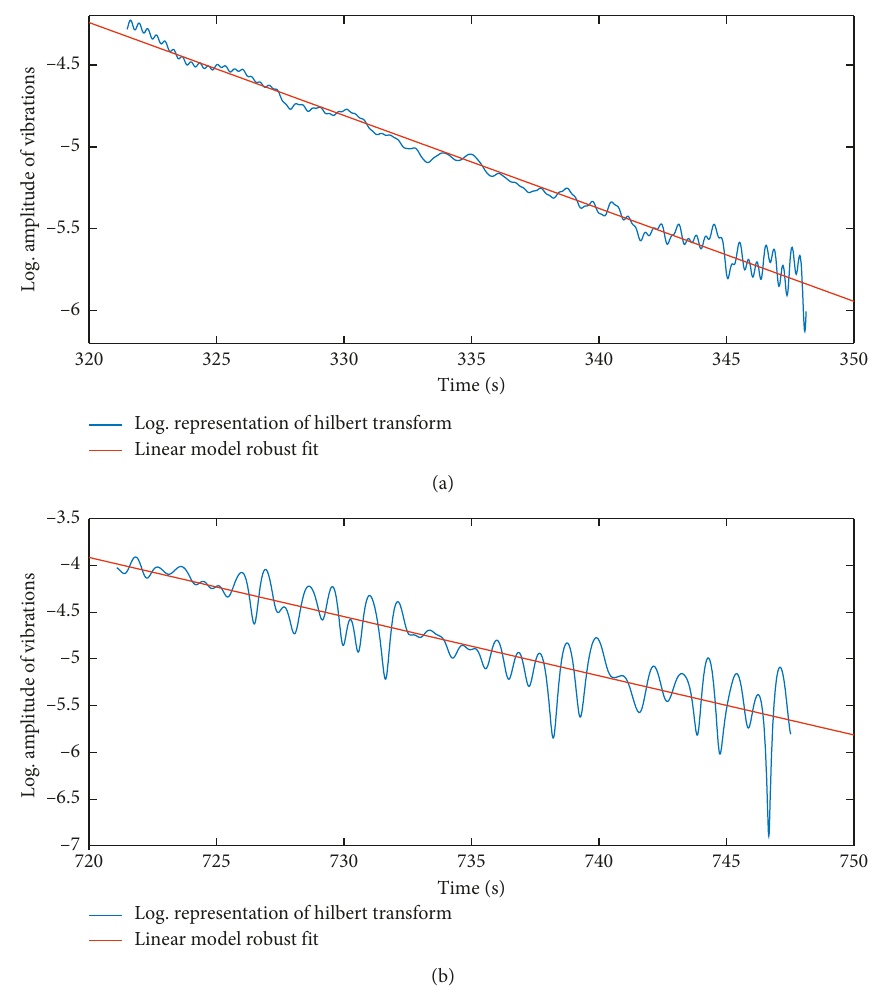
Figure 12: Logarithmic representation of Hilbert transform.